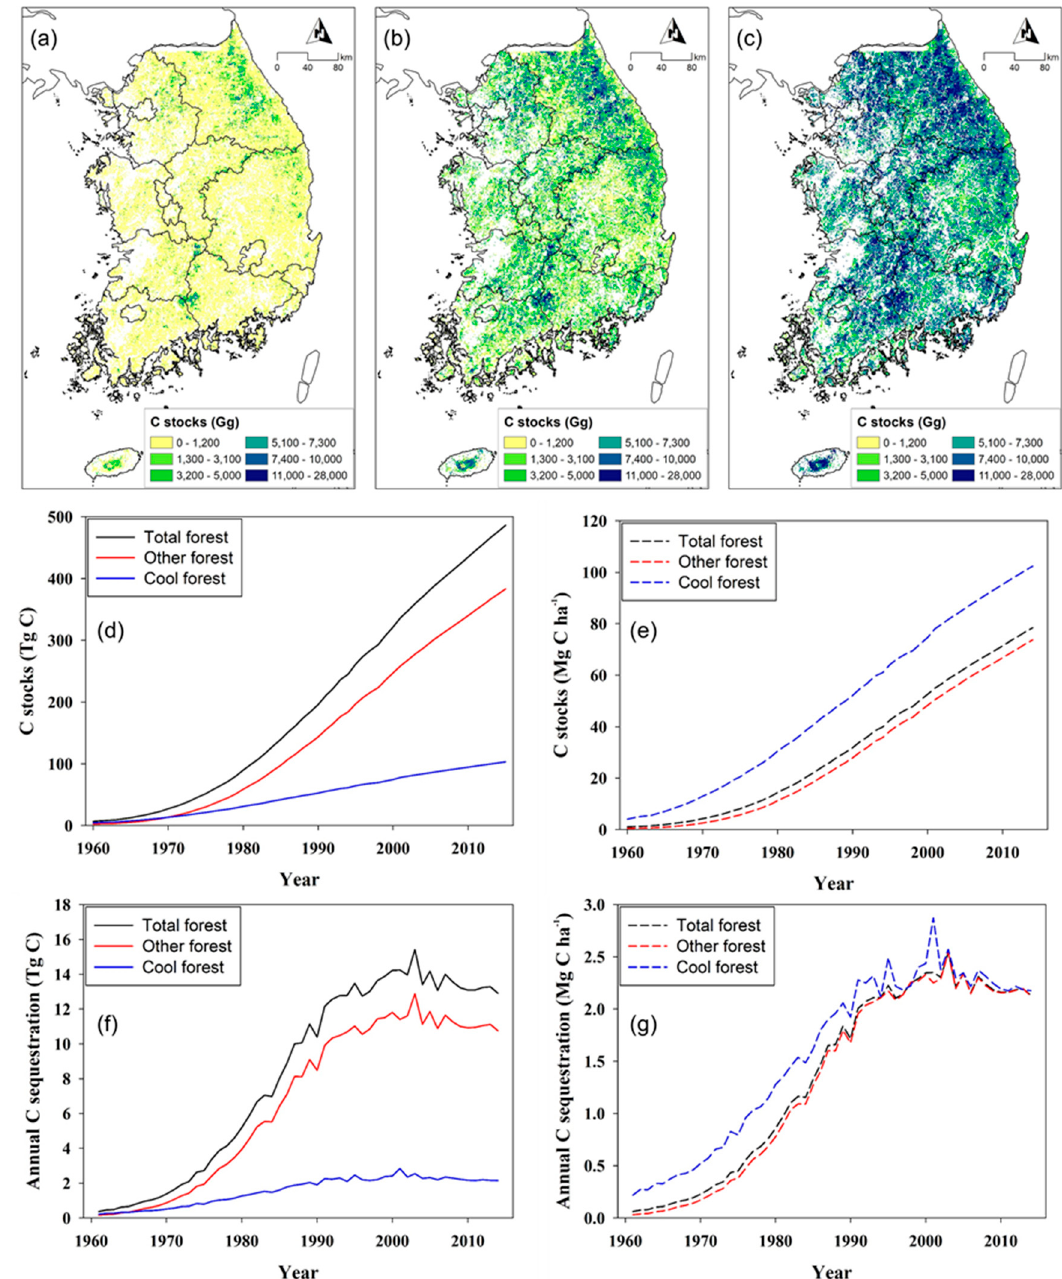
Figure 4. ( a – c ) Estimated forest carbon stock distribution in South Korea during the 1960s, the 1980s, and the 2000s. ( d – e ) Time series of total (Tg C) and mean C stocks (Mg C ha − 1 ) for three categories in South Korean forests during the simulation period. ( f – g ) Time series of total (Tg C) and mean annual C sequestration (Mg C ha − 1 ) for three categories in South Korean forests during the simulation period.